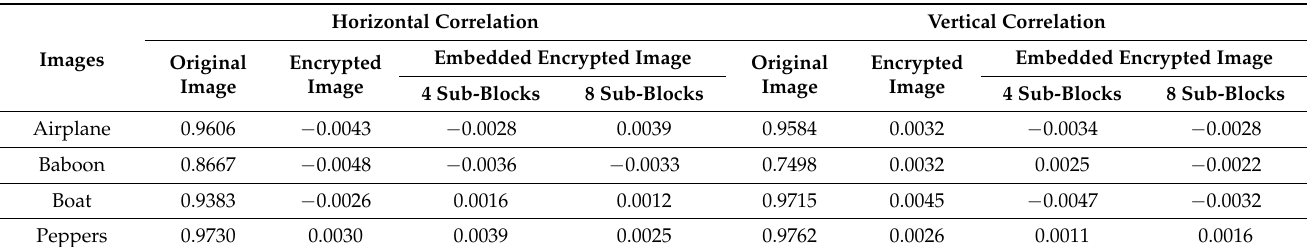
Table 7. Correlation distribution of images in different directions when the pixel block size is 8 ×